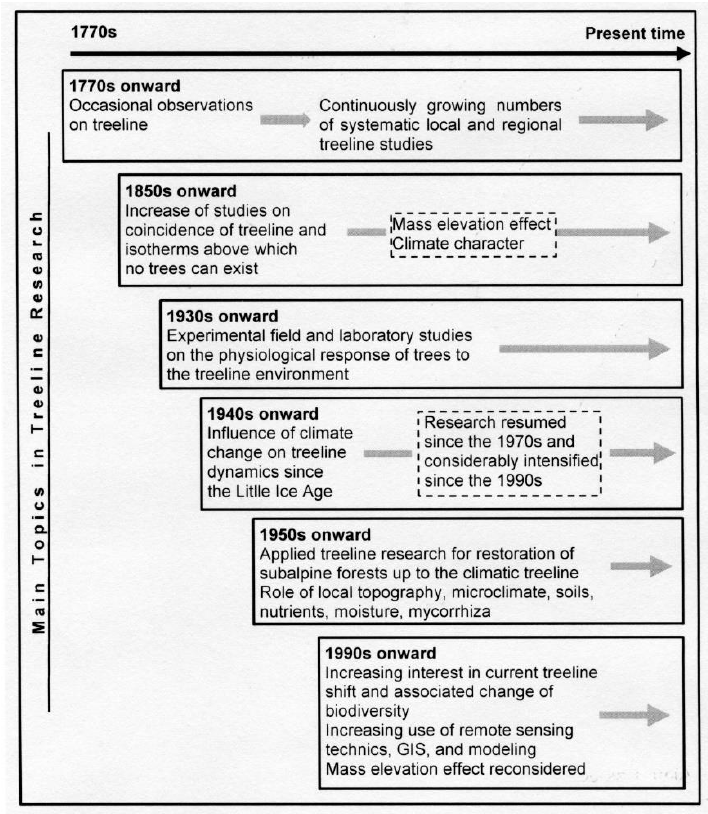
Figure 1. Scope and main topics of treeline research in the course of time.